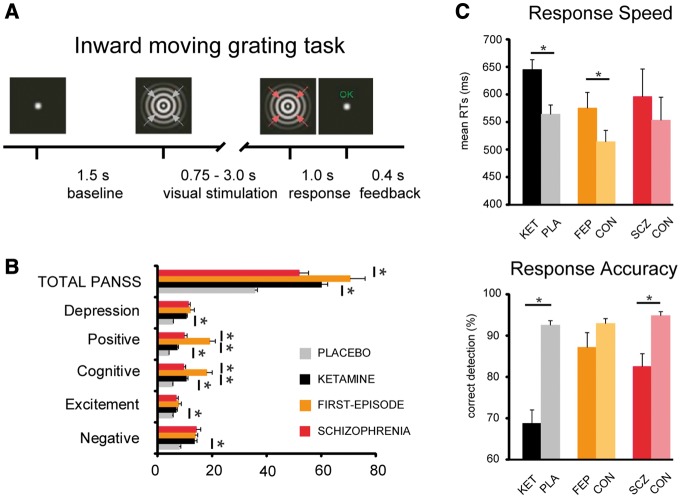

Psychopathology and behavioural performance. (A) Paradigm: participants detect increase in speed of inward moving grating (indicated by red arrows), after which the trial ends and feedback is provided. (B) Means and standard error of means for scores on PANSS ratings. Ketamine significantly increased all PANSS ratings (P < 0.0015 for excitement subitems and P < 0.001 for all others). Largest increases in symptom severity were seen for cognitive and positive symptoms (also expressed in total scores) in ketamine versus placebo condition and first-episode versus schizophrenia patients and FEP patients versus ketamine condition (all P < 0.001). (C) Mean response times (RTs, top) and response accuracy (bottom) during the inward moving grating task for the different conditions/groups. Significantly slower responses were recorded for ketamine compared to placebo in healthy individuals (P = 0.001), and between first-episode patients and their controls (P = 0.044). Response accuracy was significantly lower after ketamine infusion (P < 0.0001) compared to placebo, and in patients with chronic schizophrenia compared to controls (P < 0.001).